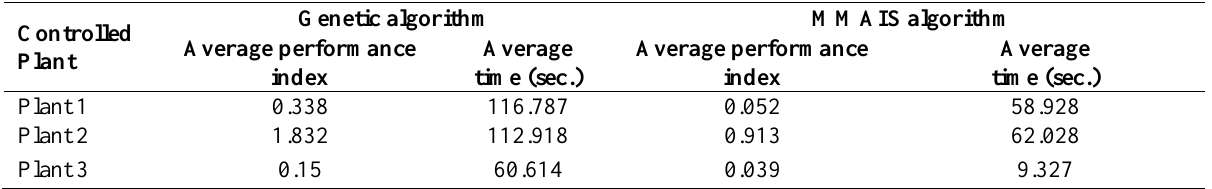
Table 2, Results of comparing the performances of the GA and the MMAIS in training the proposed SRWNN-based